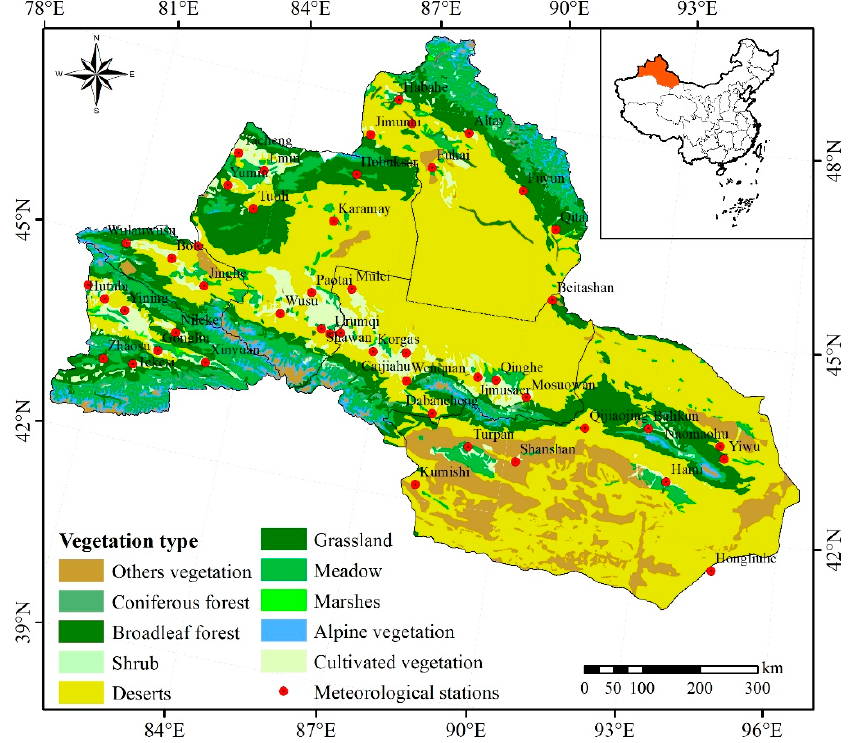
Figure1. Figure 1. A map of the NXC showing the locations of meteorological stations and vegetation distribution.